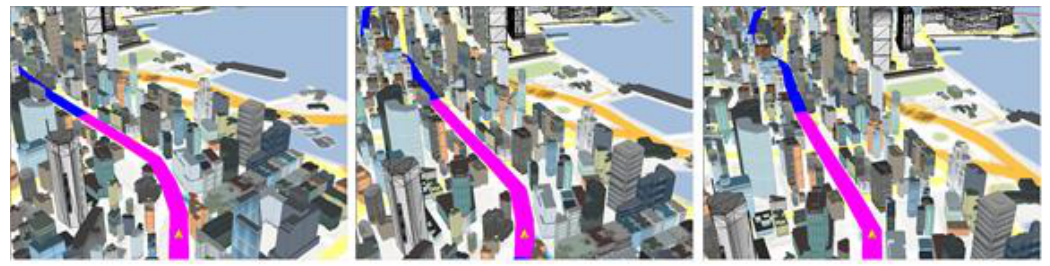
Figure 12. Animation snapshots when navigating in Vancouver. The route segments closest to the car (highlighted in pink) are disoccluded.